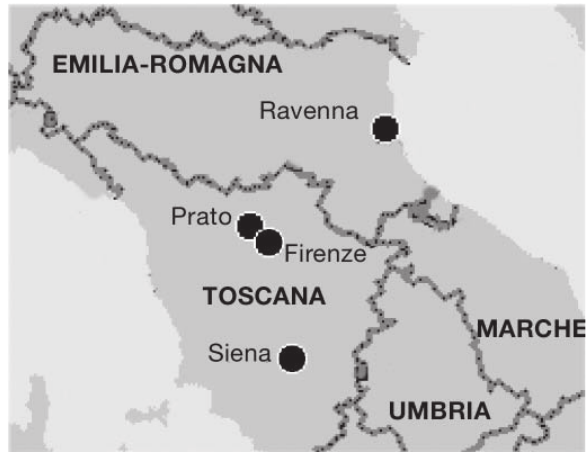
Fig. 1. Geographical location of the four vineyards ex- amined in the present